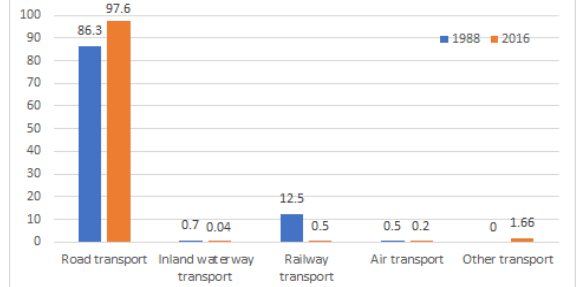
Fig. 1. CO 2 emissions from fossil fuels by sectors in Poland